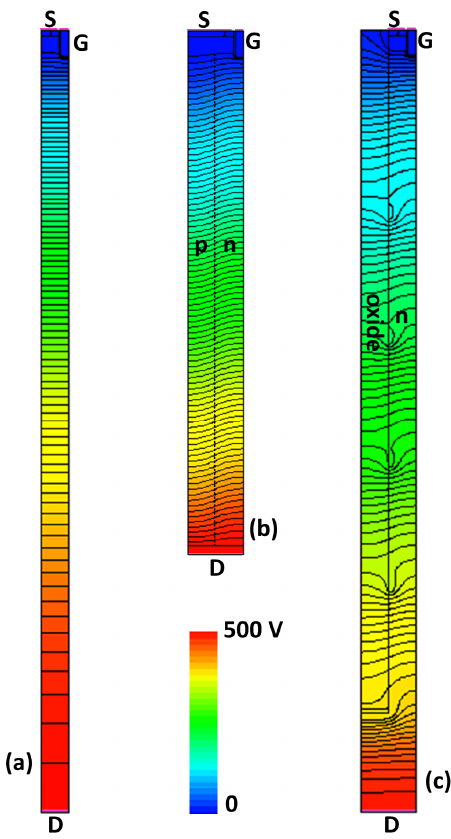
Figure 2. Electrostatic potential contour under V DS = 500 V in off-state: ( a ) conventional MOSFET, ( b ) SJ-MOSFET, and ( c ) the proposed MOSFET.